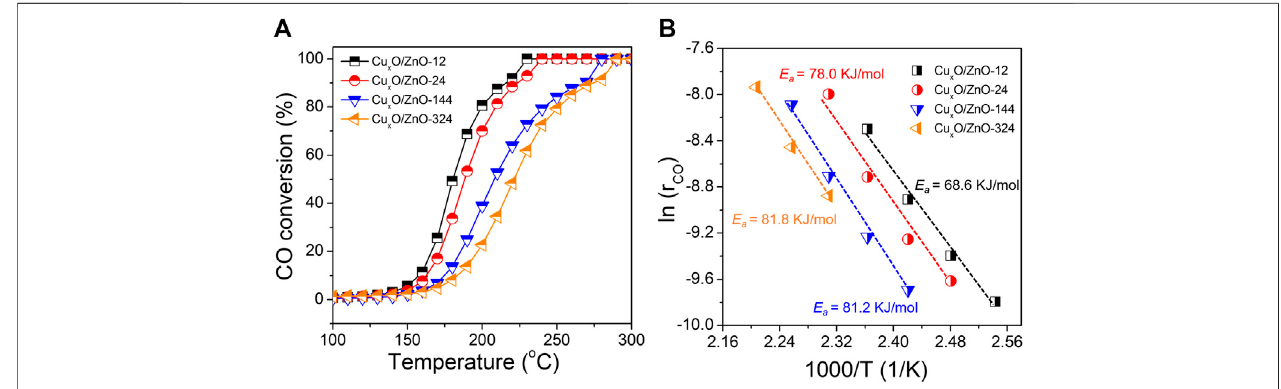
FIGURE 3 | (A) CO conversion over the catalyst series as a function of the reaction temperature; (B) Arrhenius plots of the different catalysts.